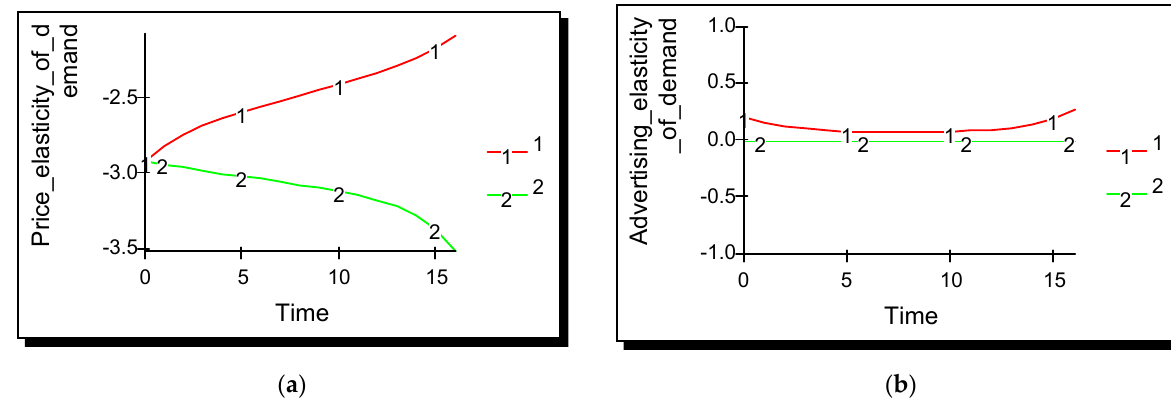
Figure 2. ( a ) Price and ( b ) advertising elasticities: Advertising effectiveness: φ 1 = 0.000011; φ 2 = 0.